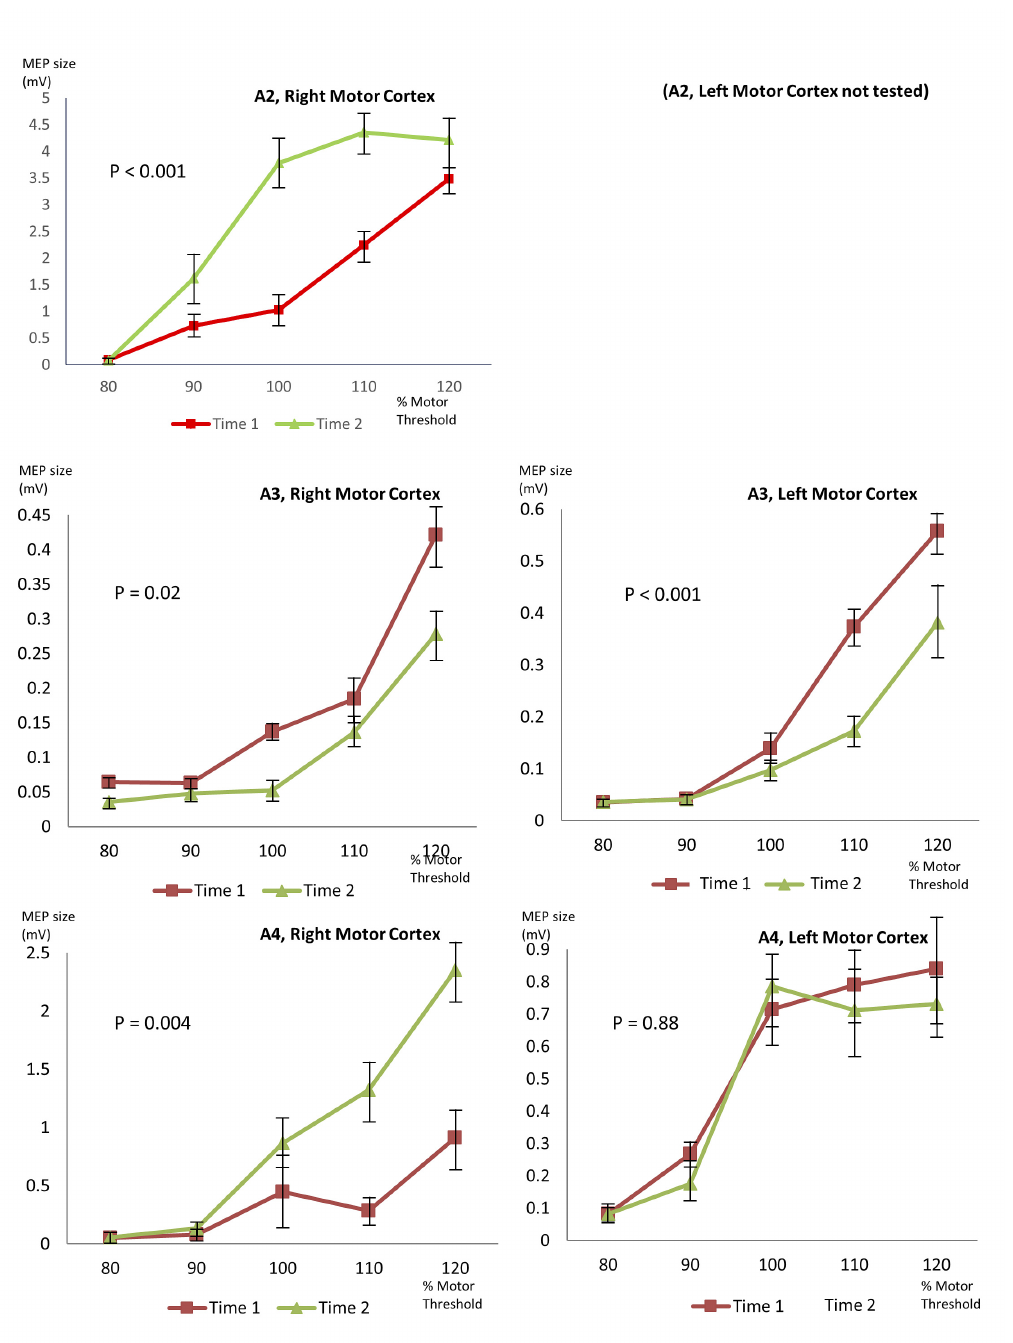
Fig 4. Variability in stimulus-response curves in people with AHC. Each graph shows two stimulus-response curves from the same subject, during the same testing session, demonstrating a change in cortical excitability. Subject 2 only tolerated testing of Right Motor Cortex, Subjects 3 and 4 were tested on both sides. P values given in the Fig were calculated using multivariate ANOVA comparing MEP size at Time 1 and Time 2, across stimulation intensities. Error bars show standard error.